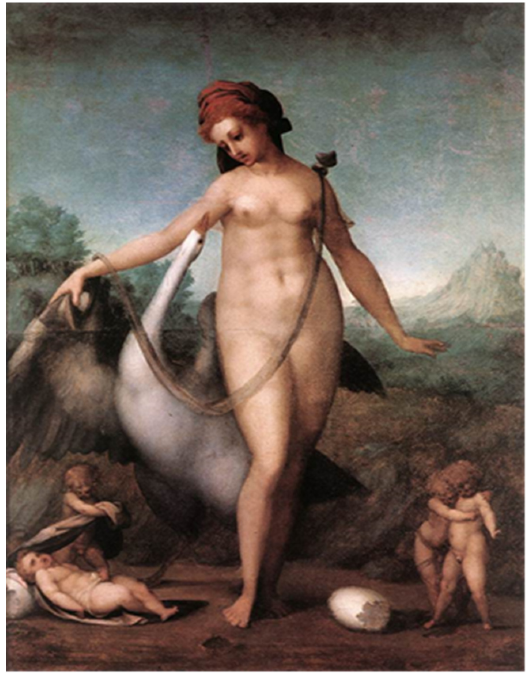
Figure 10. Jacopo Pontormo. “Leda and the Swan” (1513). the one by Leonardo (1515), of which only a copy has survived (http://commons.wikimedia.org/wiki/File:Leda_Melzi_Uffizi.jpg?uselang=ru (accessed on 25 September 2022); Figure 11):